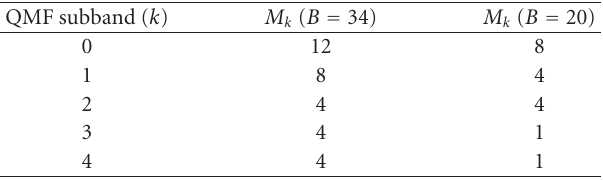
Table 2: Specification of M k for the first 5 QMF subbands. QMF subband ( k )